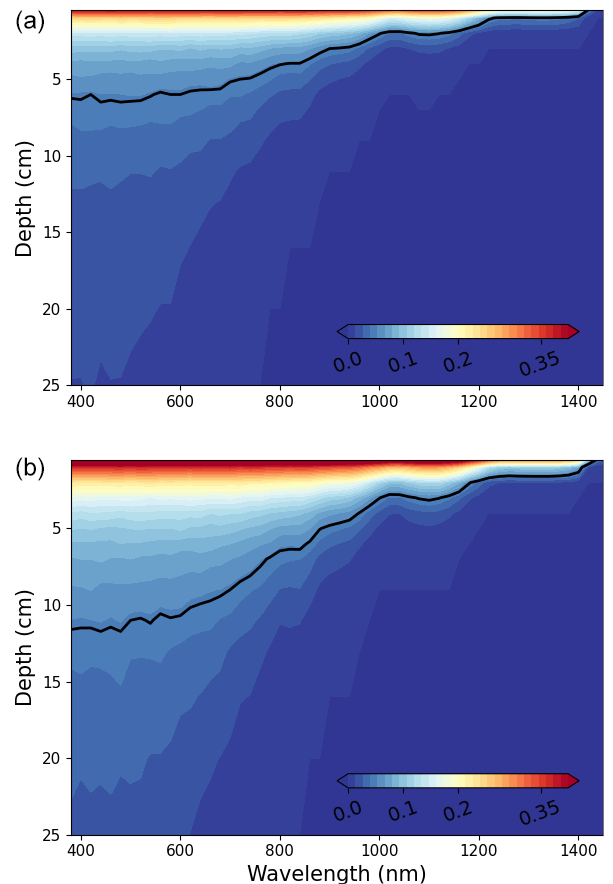
Figure 11. Simulated transmittance of (a) the fine-grain snow and (b) the coarse-grain samples contoured as a function of depth and wavelength. Solid black lines mark the depth of the 5% transmit- tance contour.